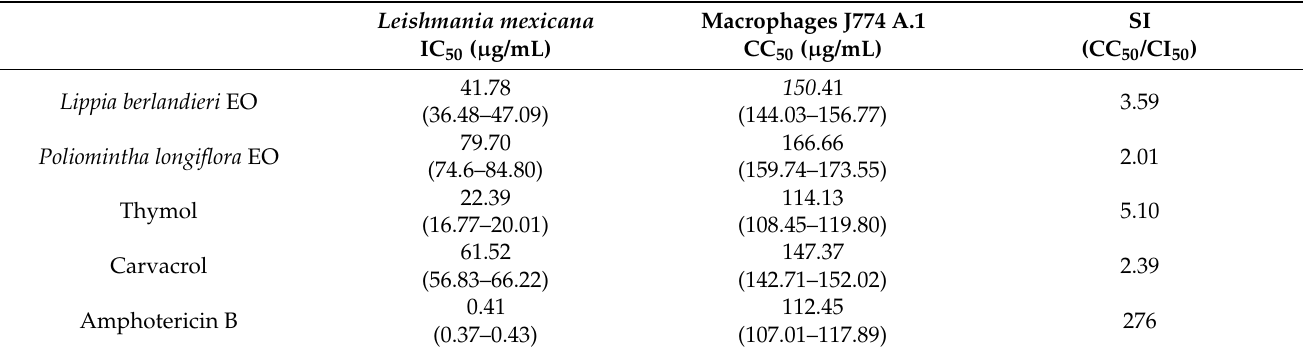
Table 1. Leishmanicidal activity of Mexican oregano essential oils and their pure major compounds. Leishmania